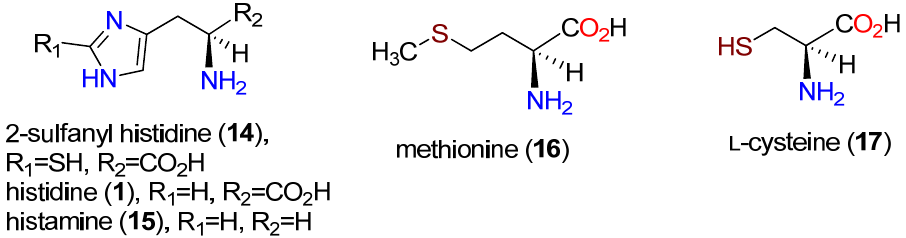
Figure 2. Structures of 2-sulfanylhistidine ( 14 ), histidine ( 1 ), histamine ( 15 ), methionine ( 16 ), and L-cysteine ( 17 ).